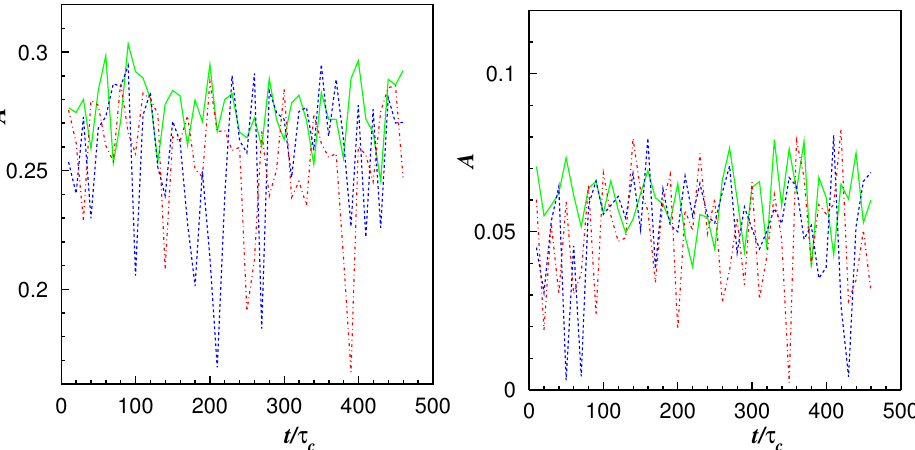
Figure 5. Time behavior of the asphericity A (values are sampled every 10 τ c ) at S ∗ = 0.80 ( left ) and S ∗ = 0.95 ( right ) for κ / ( k B TR 0 ) = 6.58 with λ = 1 (full green line), 7 (dashed blue line), 15 (dot-dashed red